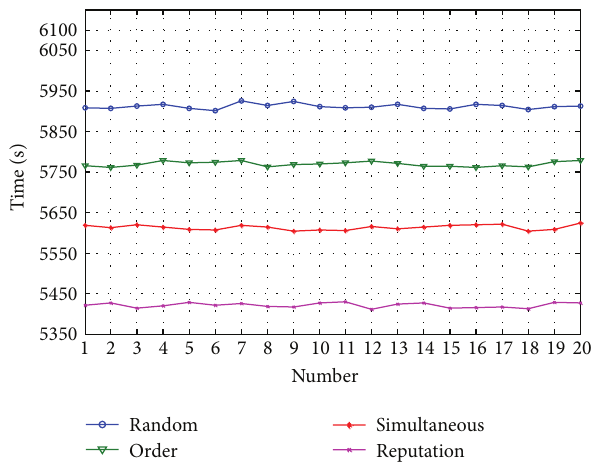
Figure 12: Comparison of large number of